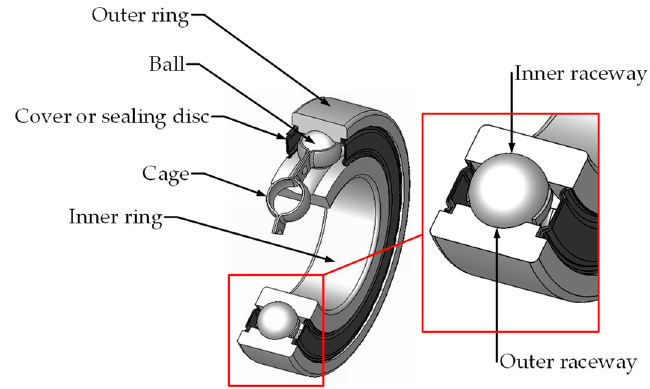
Figure 1. Diagram of the construction of a rolling bearing.